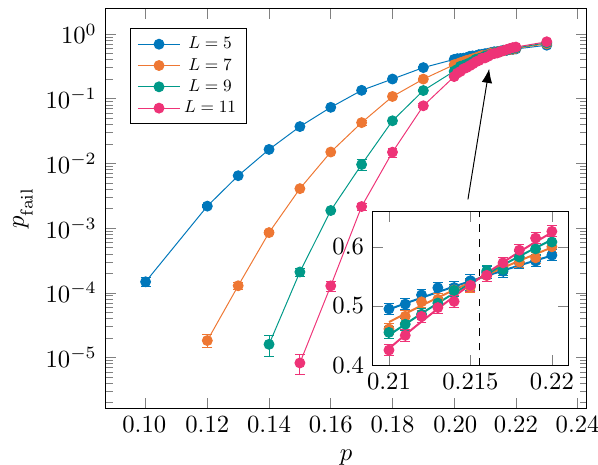
FIG. 3. Code-capacity threshold of the 3D toric code. We plot the logical error rate p fail as a function of the phase-flip error rate p for codes with linear lattice size L . The inset shows an enlargement of the threshold region, where the lines show the threshold fit described in Appendix E. All data points have at least 25 failure events. The error bars show the 95% confidence (cid:13) intervals p fail = ˆ p fail ± 1.96 p fail ( 1 − p fail )/η , where η ≥ 10 4 is the number of Monte Carlo